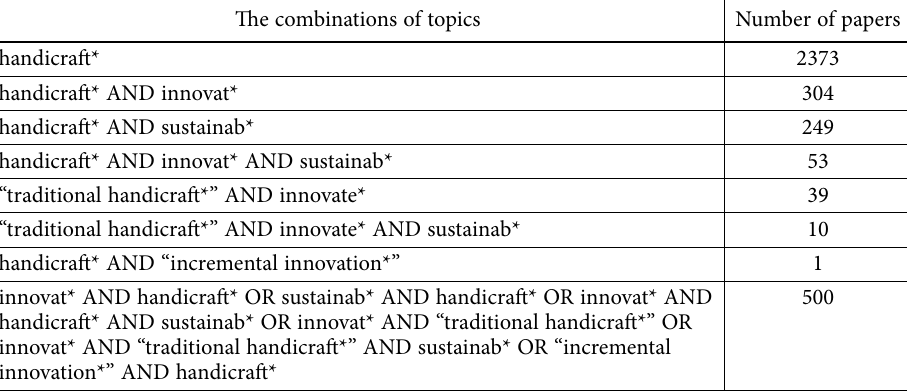
Table 2. Number of papers identified in the WoS according to the selected keywords The combinations of topics Number of